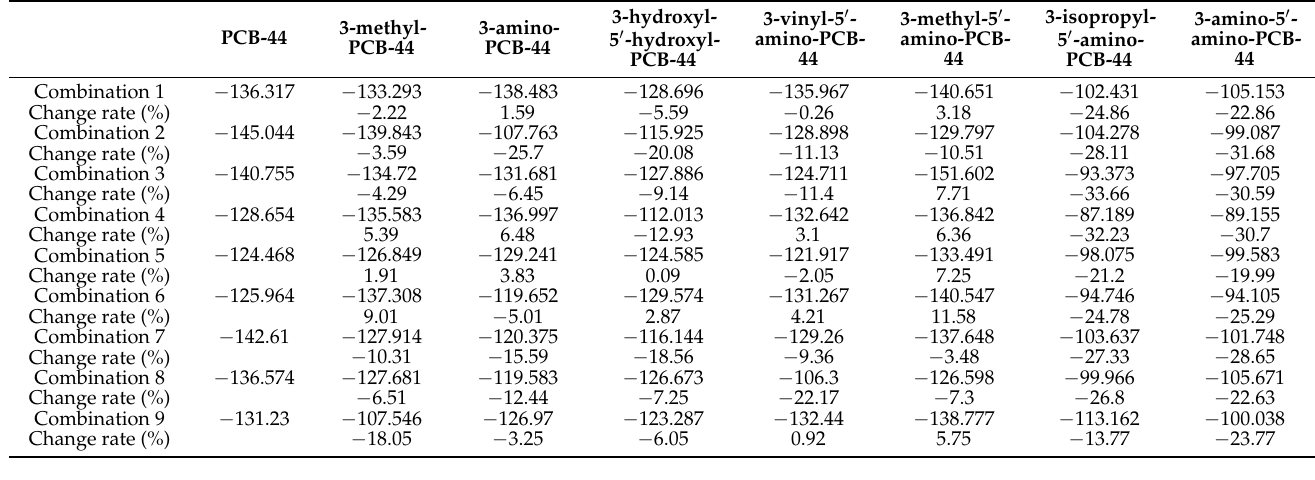
Table 7. Effect of the same external conditions on the binding of PCB-44 molecule docked to oestrogen receptor before and after modification.